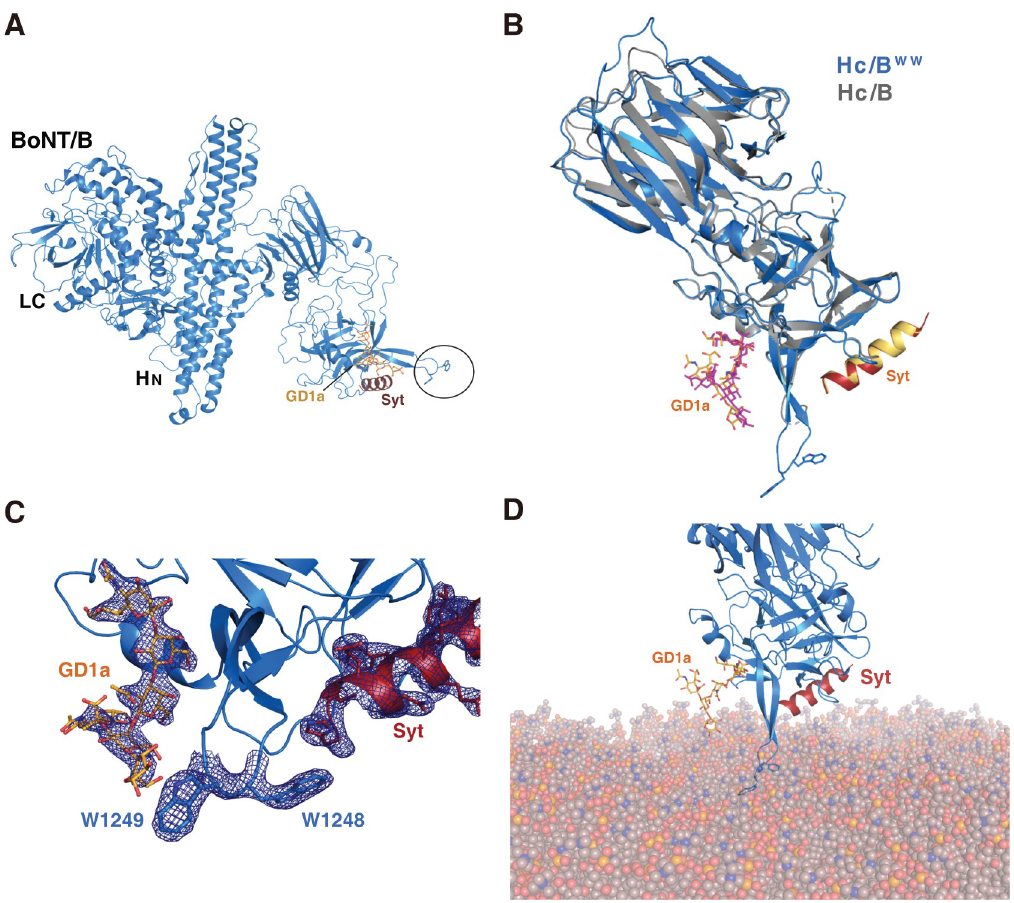
Fig 6. Cocrystal structure of H C /B WW in complex with Syt I peptide and ganglioside oligosaccharide. (A) Cocrystal structure of H C /B WW (blue) in complex with hSyt I peptide (purple) and ganglioside (yellow). The LC and H N were added from superposition with the full-length BoNT/B (PDB 1EPW). Location of the WW mutations is circled. (B) Overlay of the crystal structures of WT H C /B (gray, PDB 4KBB) and H C /B WW (blue), with the ganglioside oligosaccharide (pink and yellow, from the respective structures) and hSyt I (red)/rSyt II (yellow). The two mutated W residues are shown as sticks. (C) The region containing the GBS, Syt-binding site, and LBL is enlarged, with electron density (F o -F c map at 1 σ ) of GD1a, Syt I, and the two mutated W residues shown as a blue mesh. (D) H C /B WW is modeled onto membranes through anchoring with both GD1a and Syt I, showing that the two W residues in its LBL interact with membranes. BoNT, botulinum neurotoxin; GBS, ganglioside-binding site; GD1a, disialoganglioside; H C , C-terminal receptor-binding domain; H N , N-terminal translocation domain; hSyt I, human Syt I; LBL, lipid-binding loop; LC, light chain; PDB, Protein Data Bank; rSyt II, rat Syt II; Syt, synaptotagmin; WT, wild-type. W1248 and W1249 exposed toward the surface at the tip of LBL in H /B WW . The hydrophobic C loop of H /B WW is located in a similar position to the one in H /DC, where residues 1251– C C 1253 (YWF) protrude into the membrane bilayer (S6C Fig). These results demonstrate that introducing two tryptophan residues at this position does not alter the structure of H /B and C only extends the LBL with two surface-exposed aromatic residues. Using the extracellular domains of GD1a and hSyt I as two anchoring points, we manually docked H /B WW onto the C surface of lipid membranes, which illustrated how the two tryptophan residues would pene- trate into lipid membranes, thus providing a structural basis for H /B WW binding to lipid C membranes (Fig 6D).